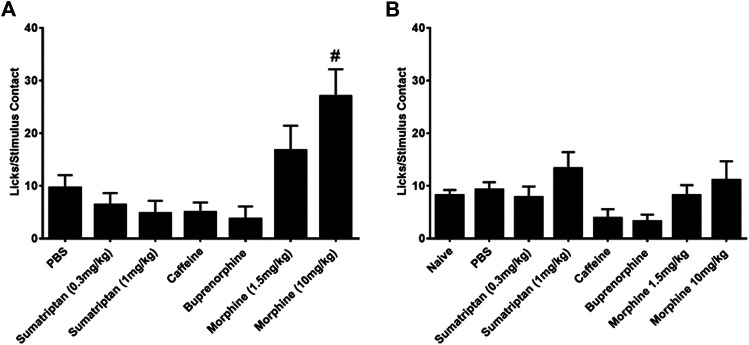
Influence of anti-nociceptive agents on the ratio of licks on the reward bottle to stimulus contacts. (A) Agents tested in the presence of 10 mg/kg nitroglycerin (i.p.). The low dose of sumatriptan (0.3 mg/kg) was given as a rescue. All other drugs were given preemptively. One-way ANOVA: F (6, 107) = 3.25, p = 0.0056, #p < 0.05 Dunnett’s test when compared to PBS. (B) Agents tested in the absence of nitroglycerin. One-way ANOVA: F (7, 150) = 1.55, p = 0.15.